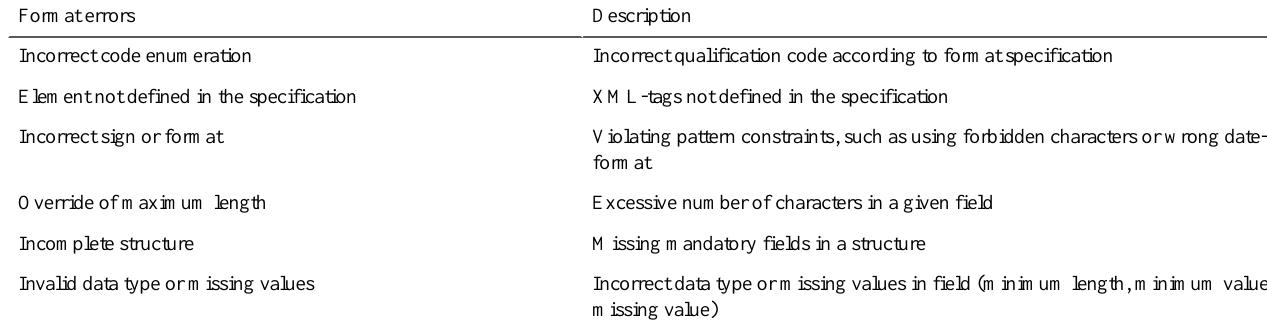
Table 3. Summary of format errors captured in ePrescriptions.